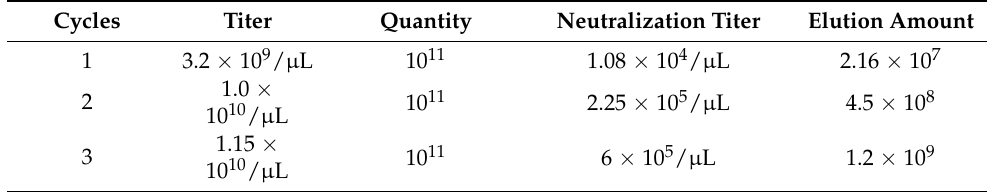
Figure 5. Positive and negative screening in phage display. Table 1. The amplified phage’s titer in each